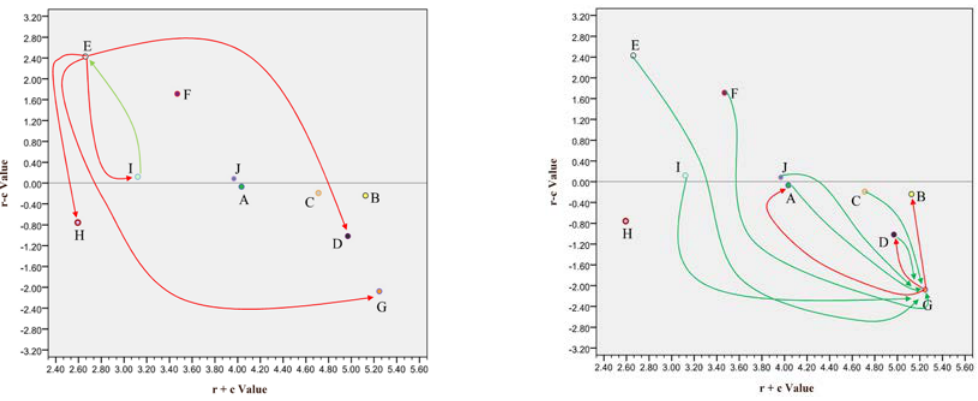
Fig. 3. The manner of direct relationships between index G and other indices (left figure), and between index E and other indices (right figure).